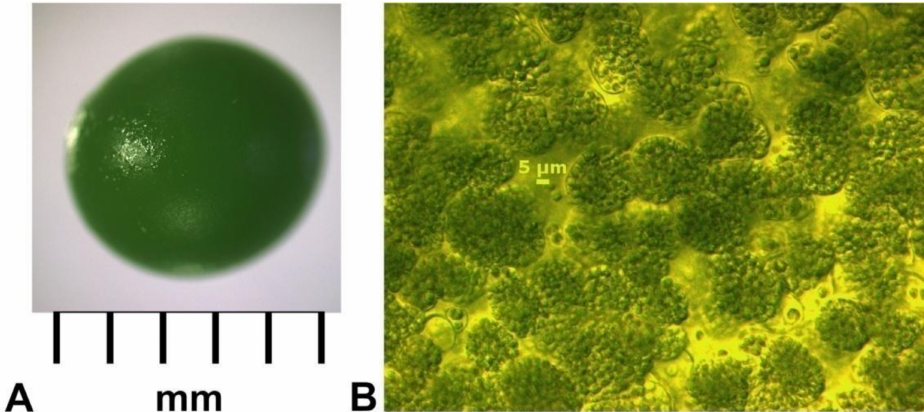
Figure 2. Chlorella vulgaris (BEIJ G-120 strain) immobilized in calcium alginate beads. ( A ) Calcium- alginate bead; ( B ) Chlorella vulgaris cells inside the calcium-alginate